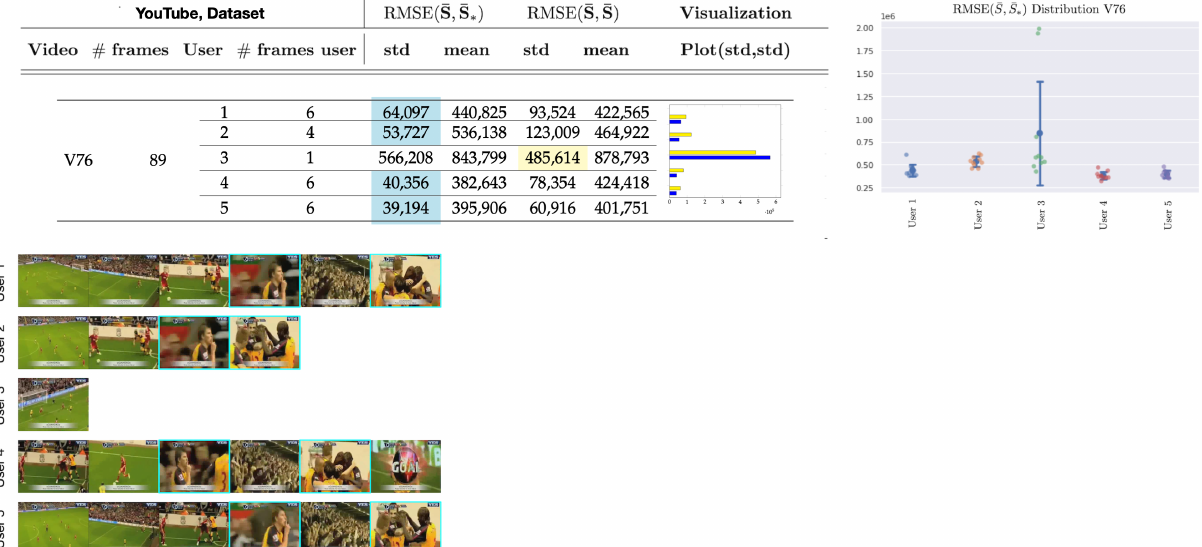
Figure 11. Visual depiction of human annotated summaries together with RMSE ( ¯ S , ¯ S RMSE ( ¯ S , ¯ S ) of video V76, Table 4. Sampling rate: 1 frame per second. Highlighted frames can increase the accuracy of the annotated summary by user 3. Highlighted values on the table corre- spond to the lowest standard deviation.